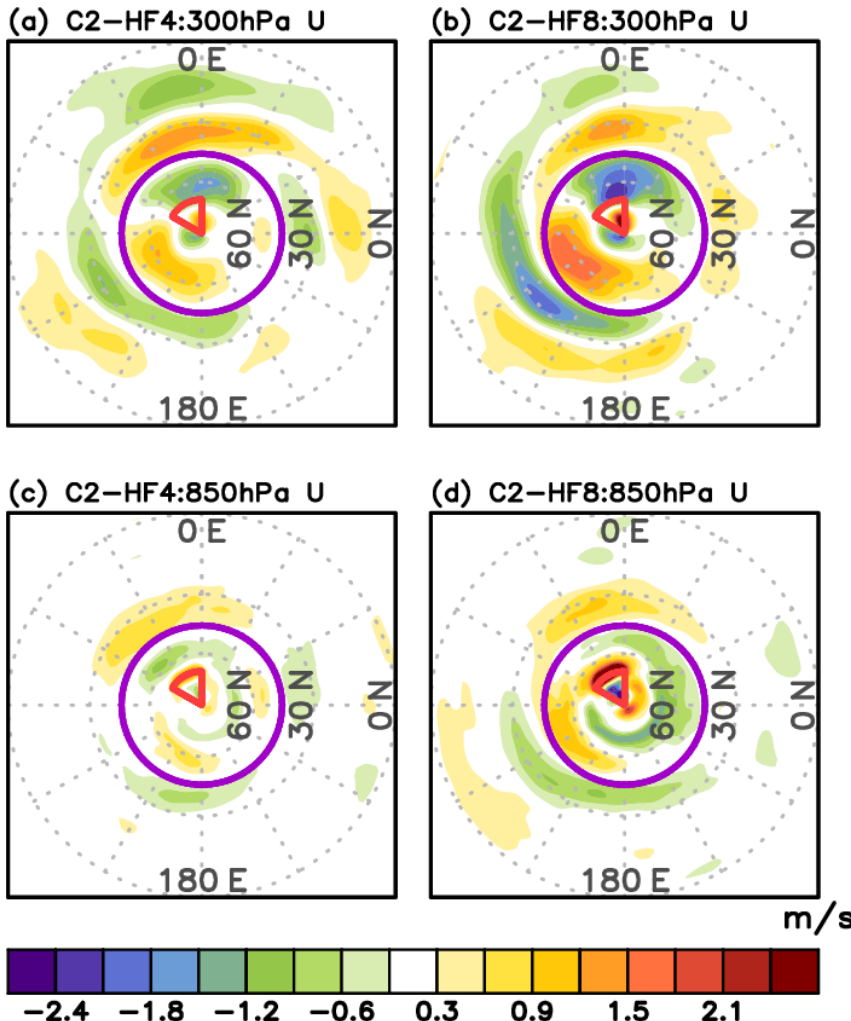
Figure 4. Time-mean zonal deviation: ( a , b ) 300 hPa zonal wind (shaded, unit: m/s), ( c , d ) 850 hPa zonal wind (shaded, unit: m/s). The purple solid line is CTRL’s eddy-driven jet position, and the red triangle represents the area of prescribing Q-flux.